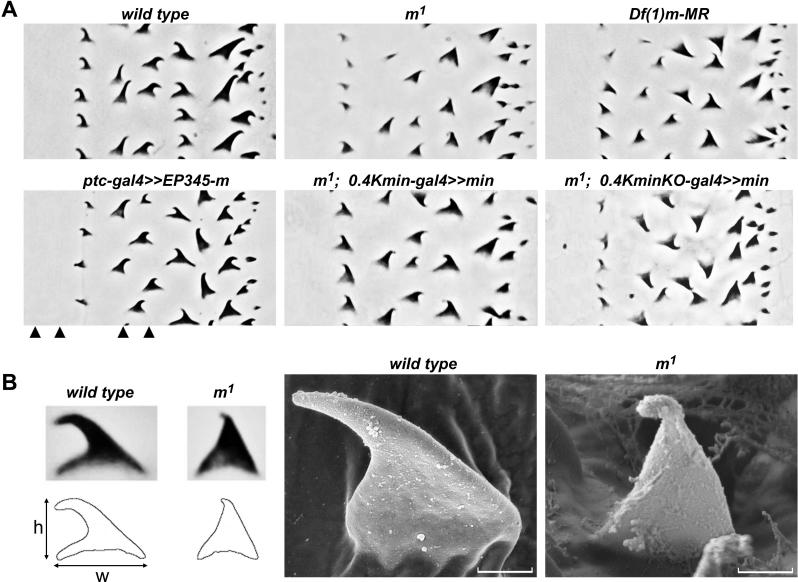

m Impinges on Denticle Formation(A) Consequences of alterations of m function and expression on denticle formation. The m1 mutation leads to morphological alteration of denticles, with a characteristic abnormal triangular shape. A similar phenotype is observed with Df(1)m-MR, a deficiency in which the entire m locus is deleted. Overexpression of m, by crossing the Ptc-Gal4 driver line to EP345-m, does not modify the cuticular phenotype in the corresponding regions (arrowheads). Re-expression of wild-type m products driven by the 0.4Kmin-gal4 transgenic lines, but not 0.4KminKO-Gal4 lines, rescues the characteristic denticles defects of m1 embryos. All pictures correspond to the A4 segment.(B) High magnification views of wild-type (wt) and m1 denticles (fourth rows of A4), as observed in either light (left) or scanning electron microscopy (right). Whereas the absence of m does not affect the denticle height (h), the width (w) is reduced, producing denticles of smaller area that display an abnormal shape lacking the median constriction characteristic of wild-type denticles. See Table S2 for quantification of these defects.